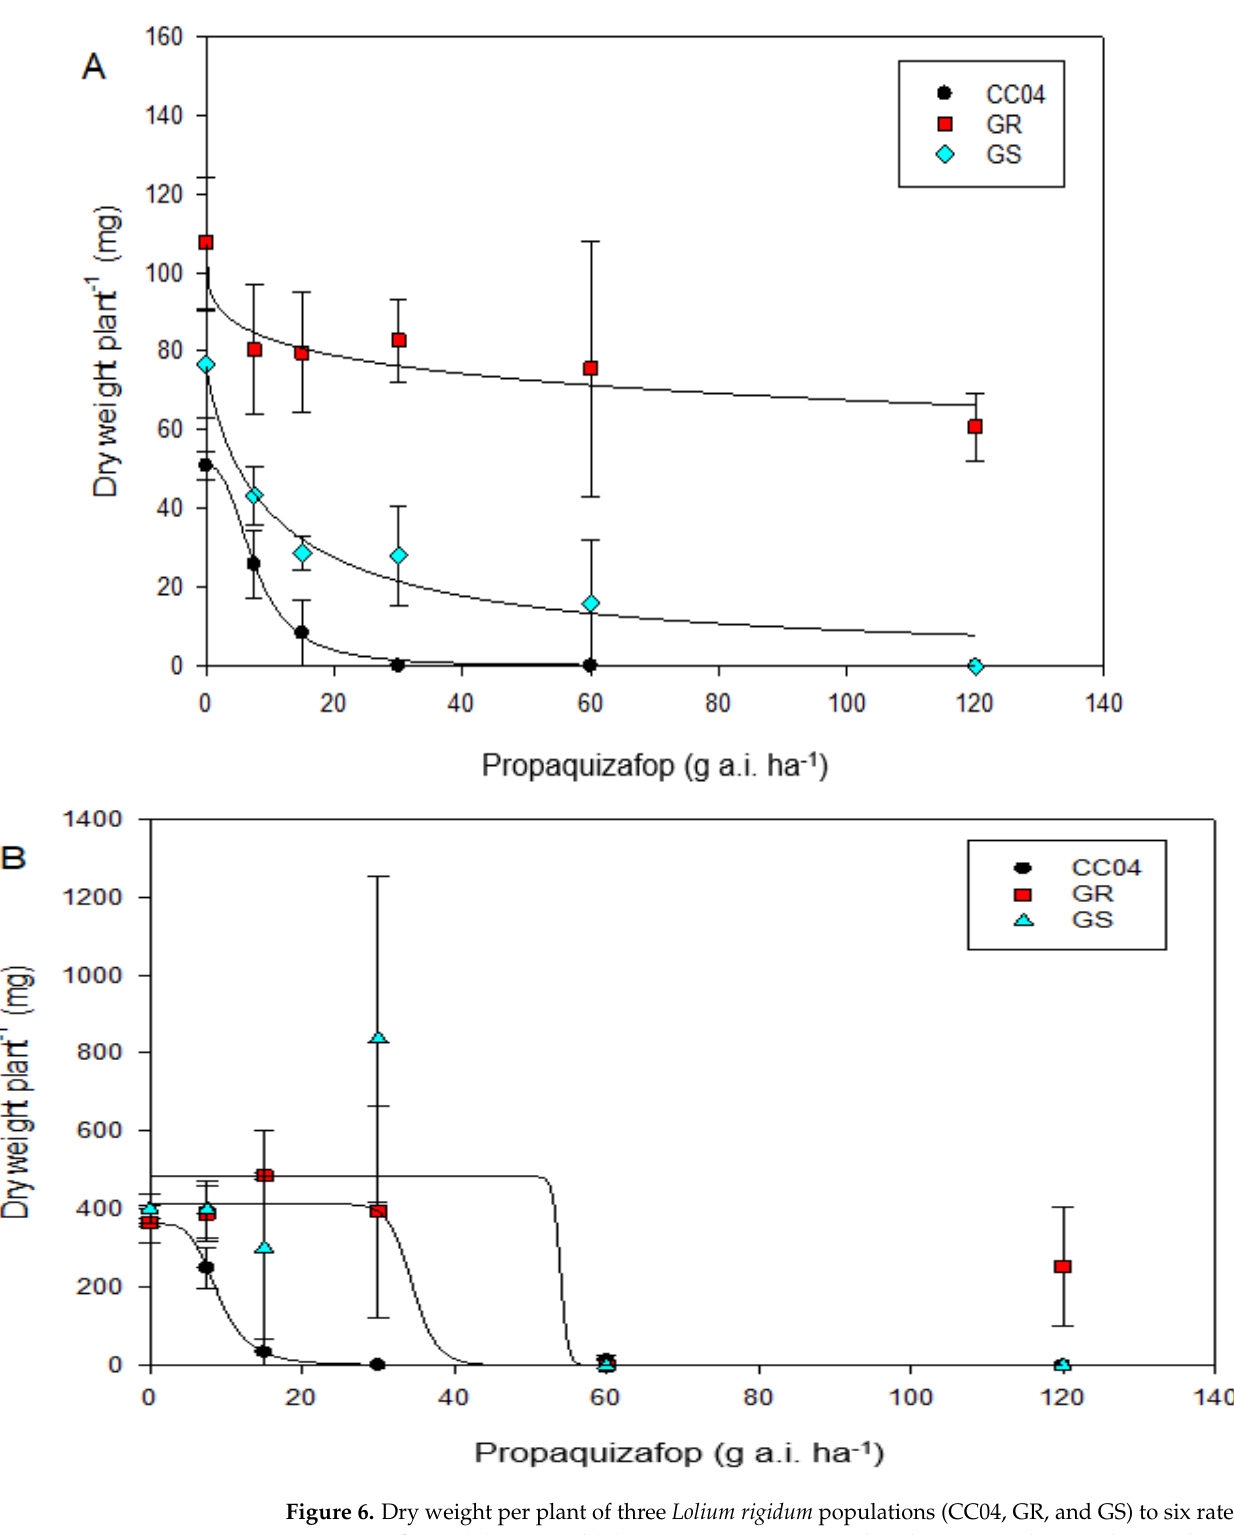
Figure 6. Dry weight per plant of three Lolium rigidum populations (CC04, GR, and GS) to six rates of propaquizafop in ( A ) 2019 and ( B ) 2021. Data are presented as the average dry weight per plant and error bars represent the standard error of the mean.